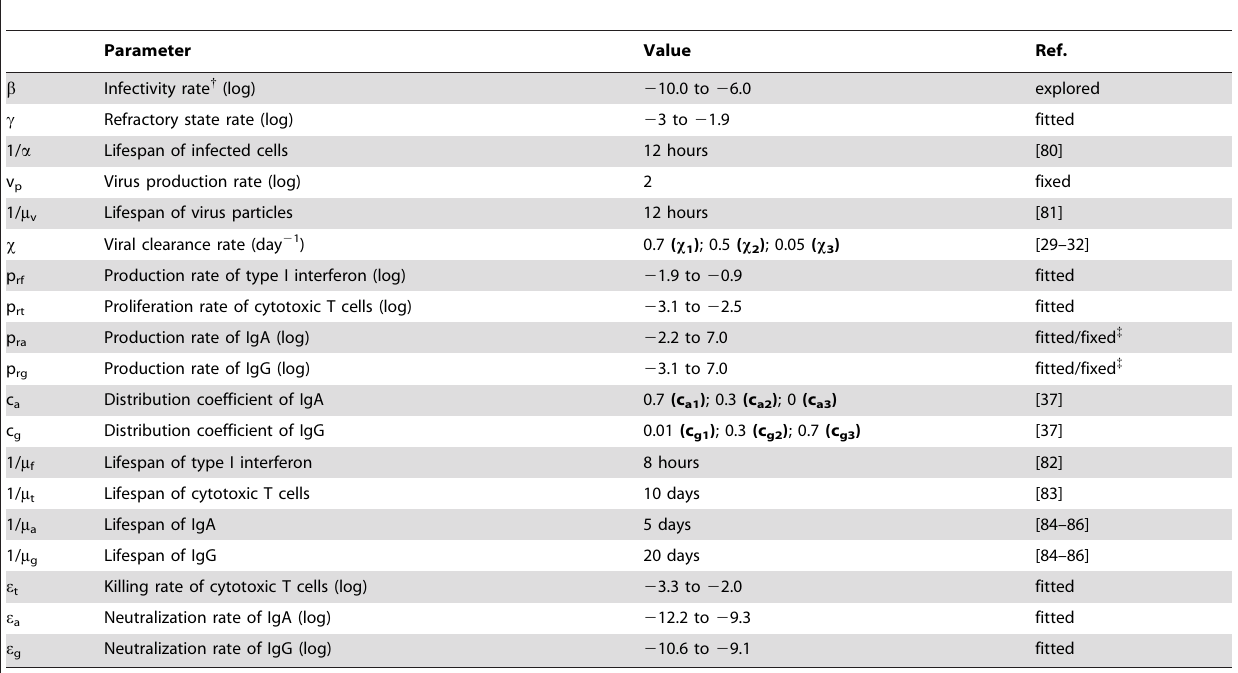
Table 2. Range of parameter estimates of the within-host models of infection